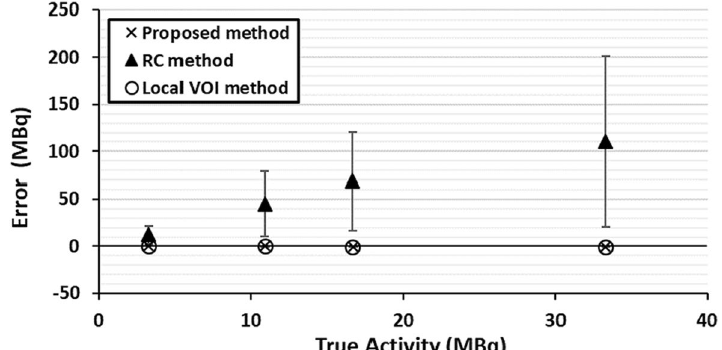
Fig. 3 Absolute errors and uncertainties for the proposed method, RC method and local background VOI method for a capsule situated in the centre of a 20‑cm‑diameter cylindrical phantom filled with cold background (water) at four time points as the capsule decayed